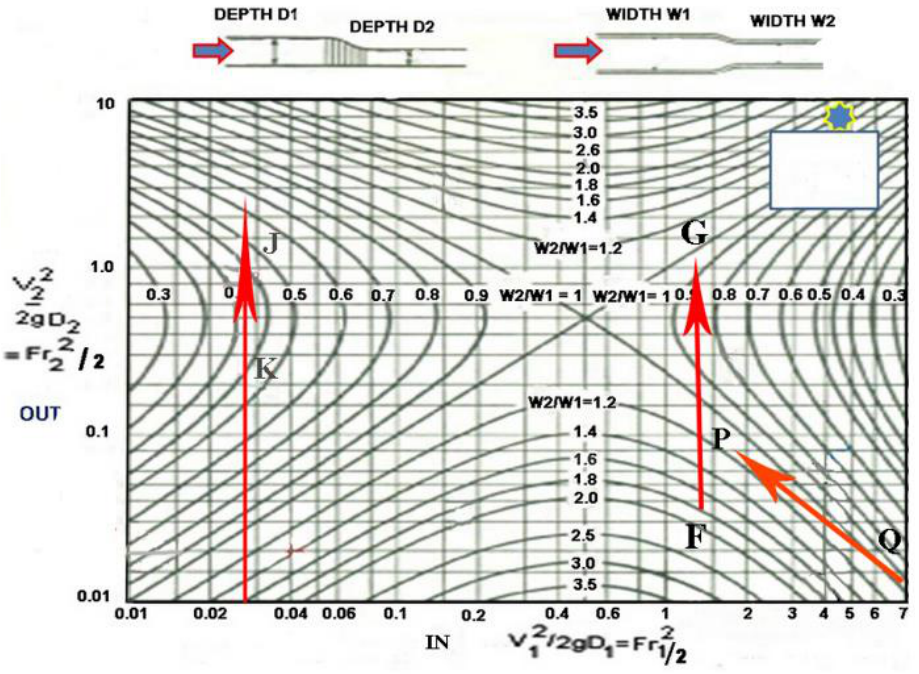
Figure 69. Froude number relationship between flow entering the channel wide section (IN) and passing through the contracted channel section (OUT) from Bakhmeteff, 1932 [47].